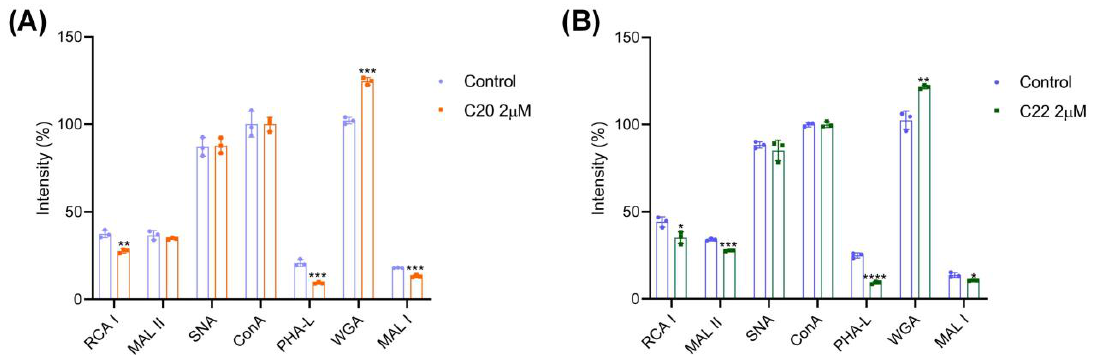
Figure 3. Lectin staining analysis of cell surface glycosylation. ( A , B ) Lectin staining of HepG2 cells after treatment with C20/C22 at a concentration of 2 µ M for 48 h ( n = 3). The displayed data correspond to the mean ± SD of three separate experiments. The p -value was analyzed by Student t -test using GraphPad Prism version 8.00. * p < 0.05, ** p < 0.01, *** p < 0.001 and **** p < 0.0001 vs. control group.